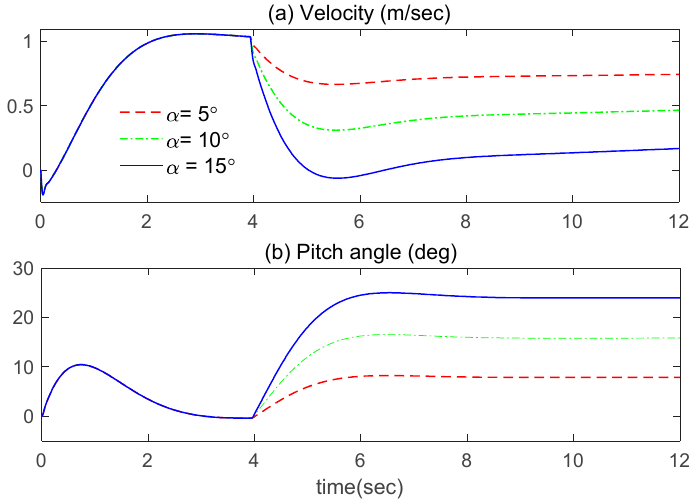
Figure 3. Uphill driving simulation on an inclined surface.